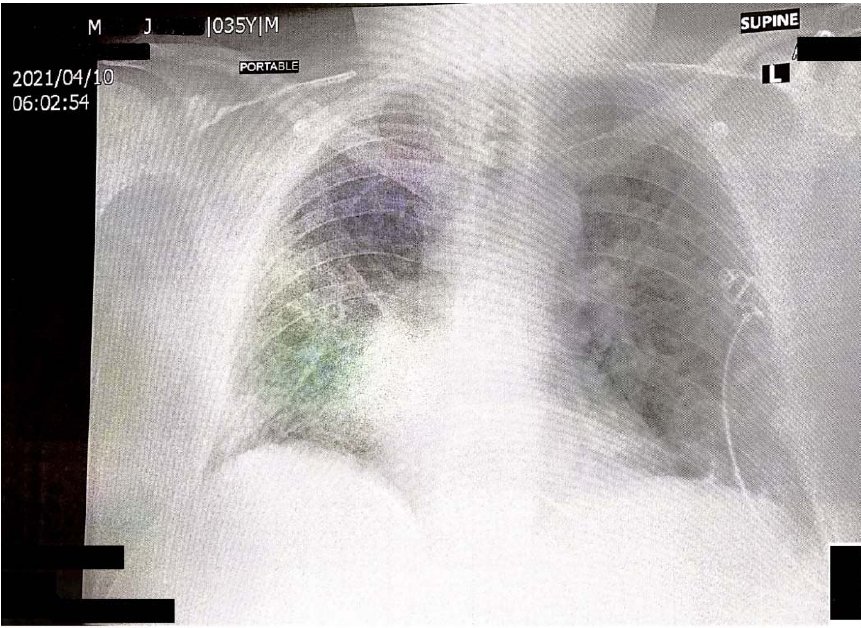
Figure 1. Chest X ‐ ray on admission—showing bilateral interstitial infiltrates without blebs. Figure 1. Chest X-ray on admission—showing bilateral interstitial infiltrates without